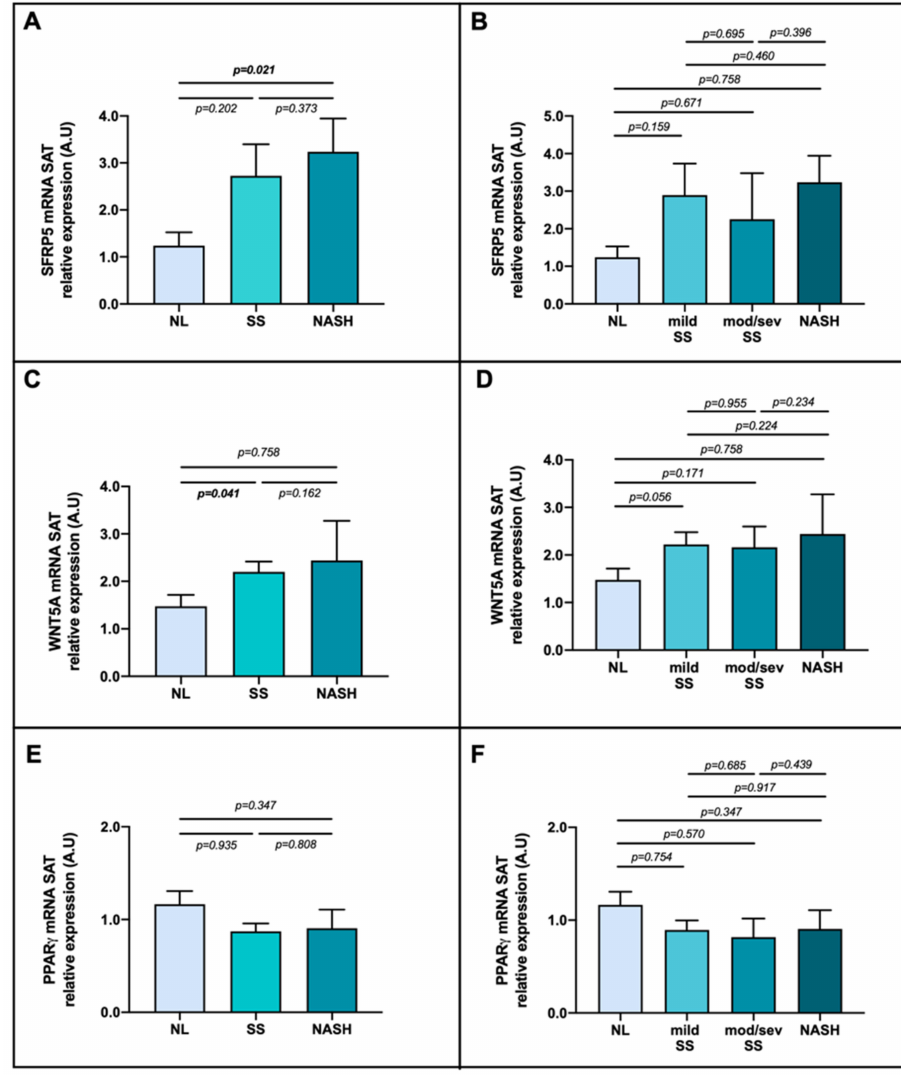
Figure 5. Differential relative mRNA abundance of ( A ) SFRP5, ( C ) WNT5A and ( E ) PPAR γ in subcutaneous adipose tissue of women with MO classified by their liver histology as NL, SS and NASH; also, differential relative mRNA abundance of ( B ) SFRP5, ( D ) WNT5A and ( F ) PPAR γ classified as NL, mild SS, mod/sev SS, and NASH depending on the histopathological groups. The data were normalized by NL group and expressed as mean standard error of the mean (SEM). SAT, subcutaneous adipose tissue; SFRP5, secreted frizzled-related protein 5; WNT5A, WNT family member 5a; PPAR γ , peroxisome proliferator-activated receptor gamma; MO, morbid obesity; SS, simple steatosis; mod/sev SS, moderate and severe SS; NASH, nonalcoholic steatohepatitis; A.U arbitrary units. p < 0.05 was considered statistically significant